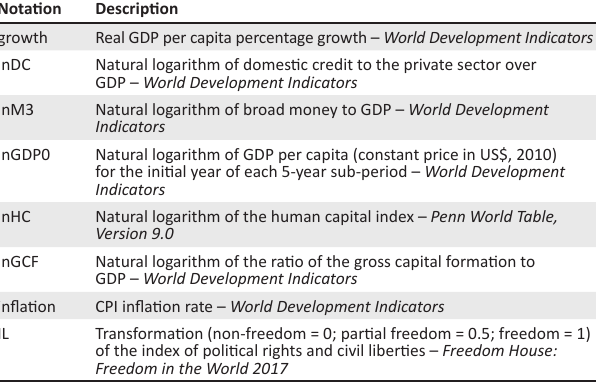
TABLE 1: Definitions and sources of variables. Notation